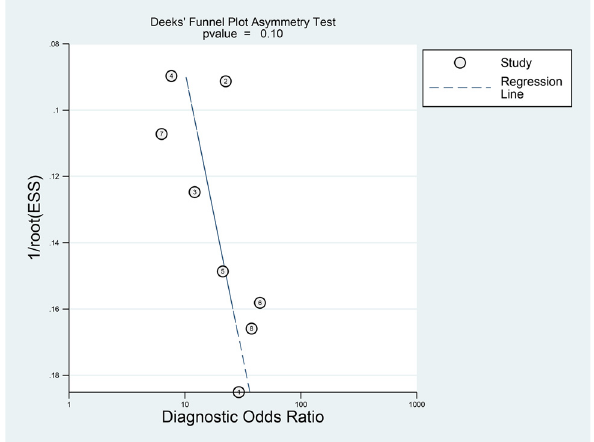
Figure 7: Publication bias evaluated by Deeks ’ funnel